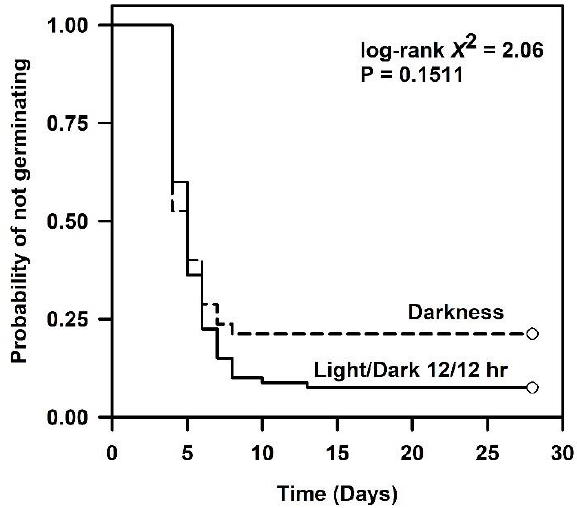
Figure 3. Kaplan–Meier estimates of survivor functions for Linum arenicola seeds exposed to 12 h alternating photoperiod or dark conditions under constant 22 °C. Pointwise 95% confidence intervals omitted for clarity.